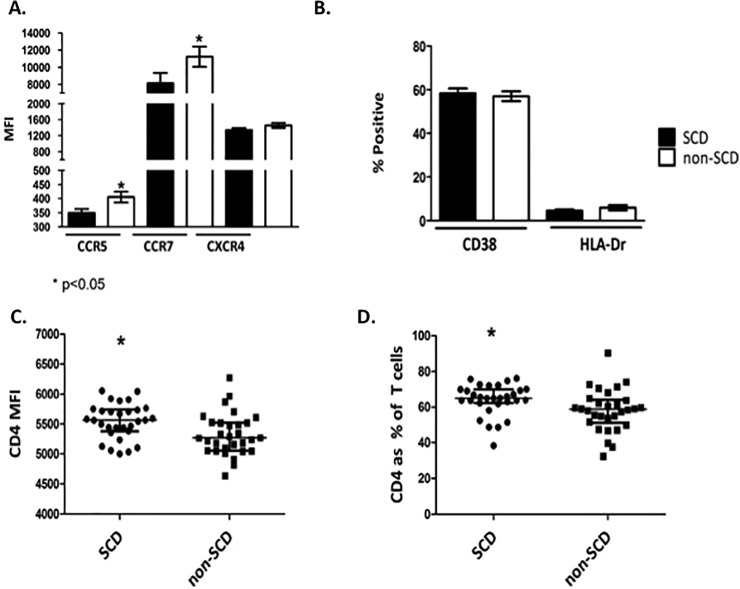
Comparison of HIV co-receptors, CD4+ T cell activation markers, CD4+ MFI and Percent of CD4+ Cells Among Total T Cells between SCD patients and non-SCD controls.Twenty four-hour old whole blood samples from SCD patient and non-SCD controls were labeled for CD4 T cells and incubated with antibodies to detect markers associated with HIV or cellular activation. Following incubation, surface expression of the HIV co-receptors CCR5 and CXCR4 and T cell trafficking molecule CCR7 were measured by flow cytometry (Panel A). MFI, mean fluorescence intensity between SCD patients and non-SCD controls were compared. Percent of CD4+ T cells expressing the activation markers CD38 or HLA-DR were measured and compared between SCD patients and non-SCD controls (Panel B). The intensity of expression of CD4+ amongst T cells (Panel C) and the percent of CD4+ T cells among total T cells (Panel D) was significantly higher in SCD patients compared to non-SCD controls. Mean and standard errors of the means for 30 SCD patients and 30 non-SCD controls are shown, *p<0.05.